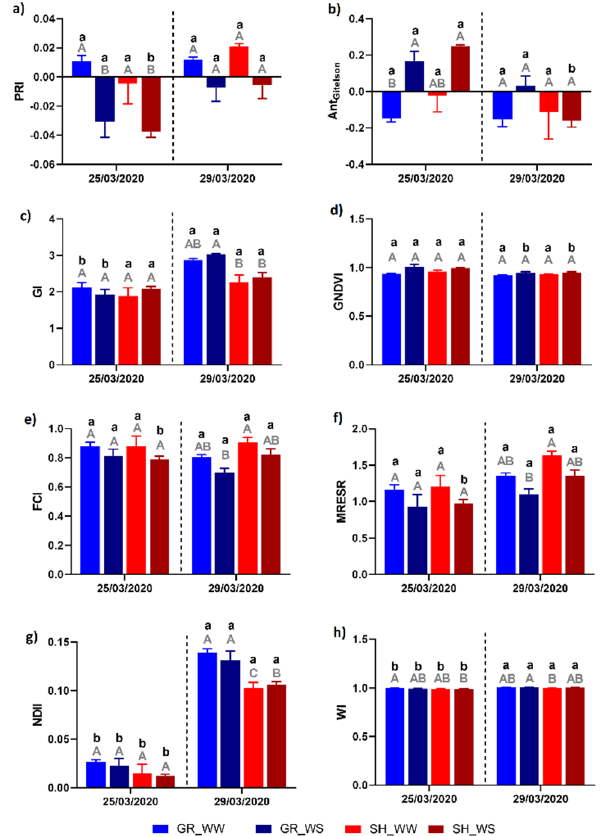
Figure 4. Variation in the VIs for well-watered (WW) and water-stressed (WS) Grenache (GR) and Shiraz (SH) under high temperature: ( a ) PRI, ( b ) Ant Gitelson , ( c ) GI, ( d ) GNDVI, ( e ) FCI, ( f ) MRESR, ( g ) NDII, and ( h ) WI. Each data point is the mean + standard error of the mean of three replicates. Different small black letters indicate statistically significant difference at p ≤ 0.05 over time within the same treatment. Means were separated by unpaired two-tailed t -test using Tukey’s least significant difference (LSD) test. Different capital grey letters indicate significant difference between treatments within the same date. Means were separated by one-way ANOVA using Tukey’s LSD test.